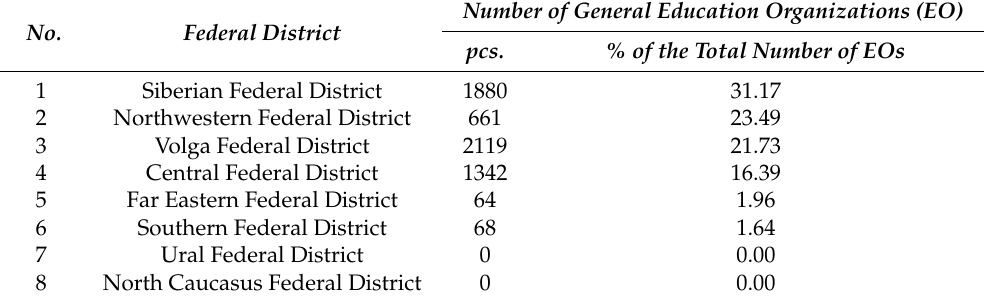
Table 6. The number of general education institutions using information resources for the automated assessment of satisfaction of schoolchildren and their parent with the organization and quality of meals by federal districts of the Russian